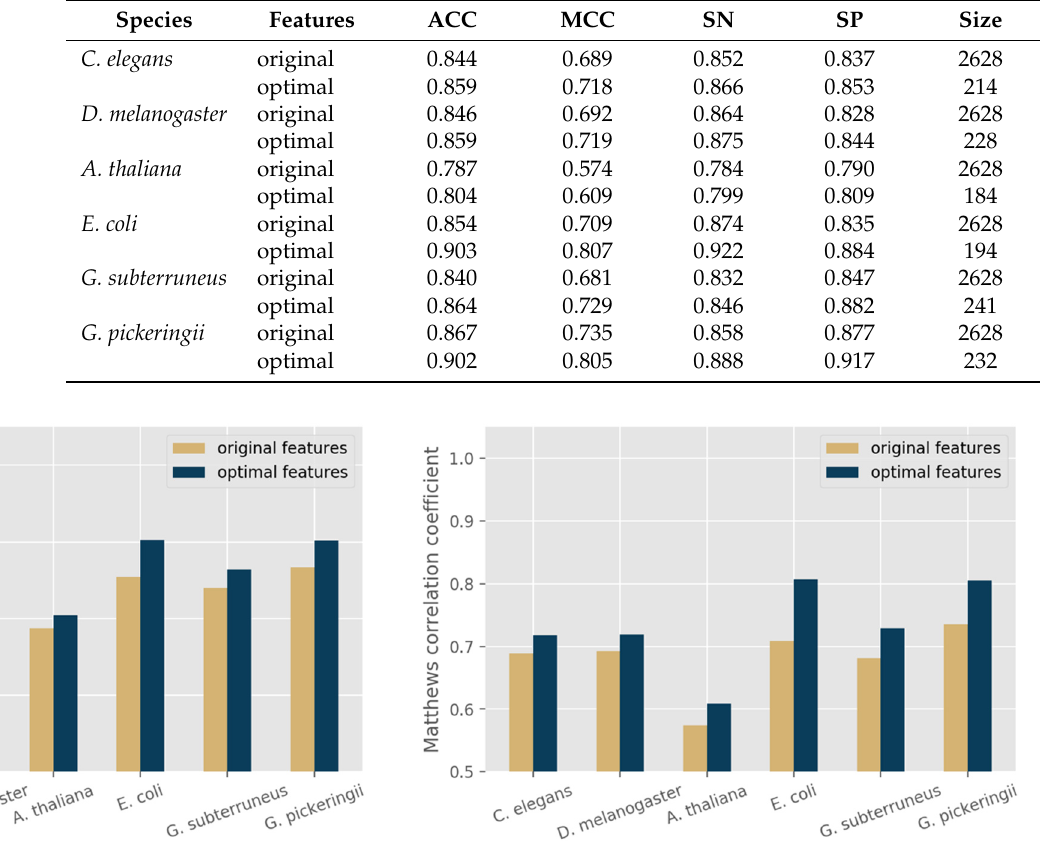
Figure 4. Performance of the original features and optimal features on the Accuracy and Matthews correlation coefficient metrics. Table 2. Comparison between the original features and optimal features.